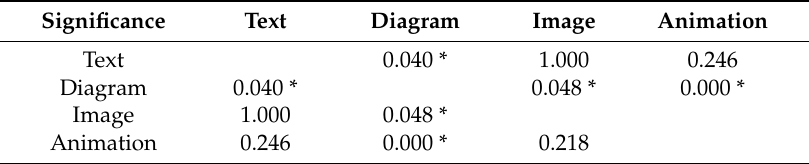
Figure 8. Comparison of affective valences (unit: points; nine-point Likert scale). Table 8. Post-hoc test of affective valence: significance of the four interfaces.